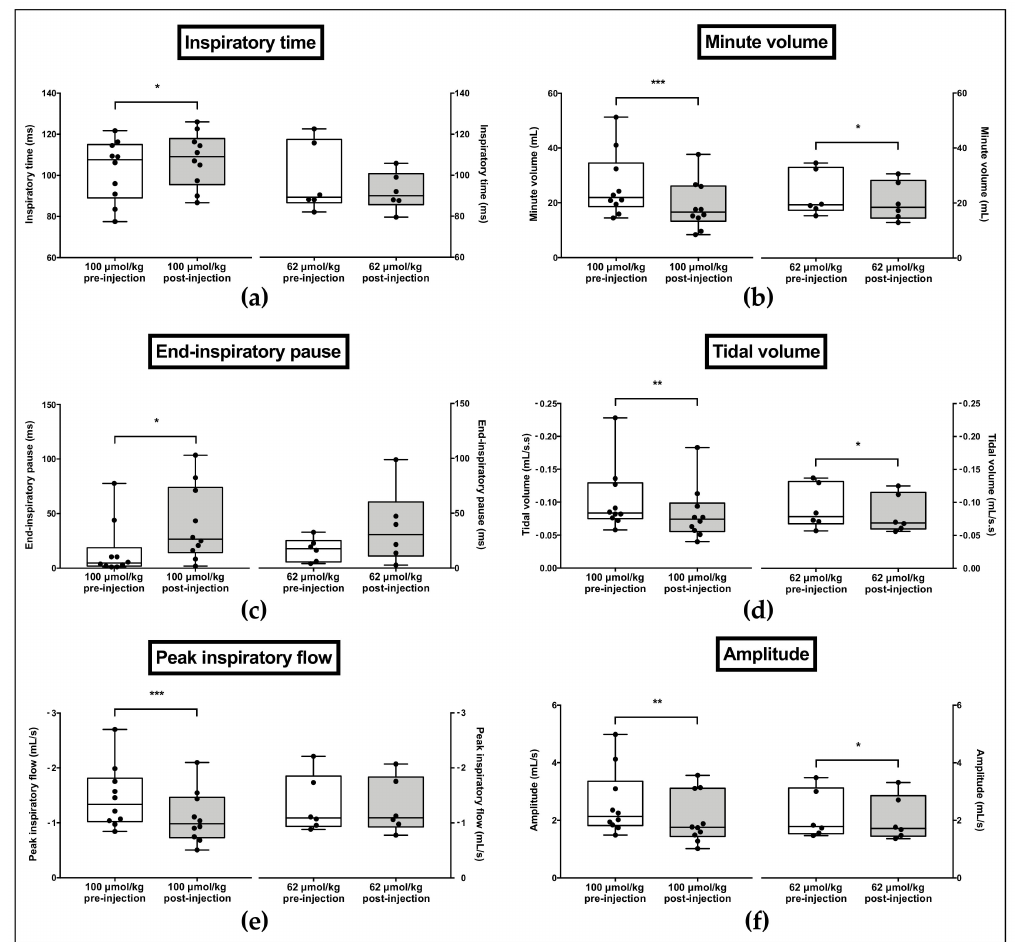
Figure 10. E ff ects of i.p. administration of 100 µ mol / kg or 62 µ mol / kg KM297 HCl on ventilatory parameters recorded by double-chamber plethysmography: inspiratory time ( a ), minute volume ( b ), end-inspiratory pause ( c ), tidal volume ( d ), peak inspiratory flow ( e ) and amplitude (f) . n = 6–10. The line in the middle of the box is plotted at the median. Each individual value is represented as black circles. Whiskers range from the maximum value to minimum value. Comparisons were performed using paired t-tests for normally distributed variables or Wilcoxon tests in case of non-Gaussian distribution. * p < 0.05, ** p < 0.01, *** p <